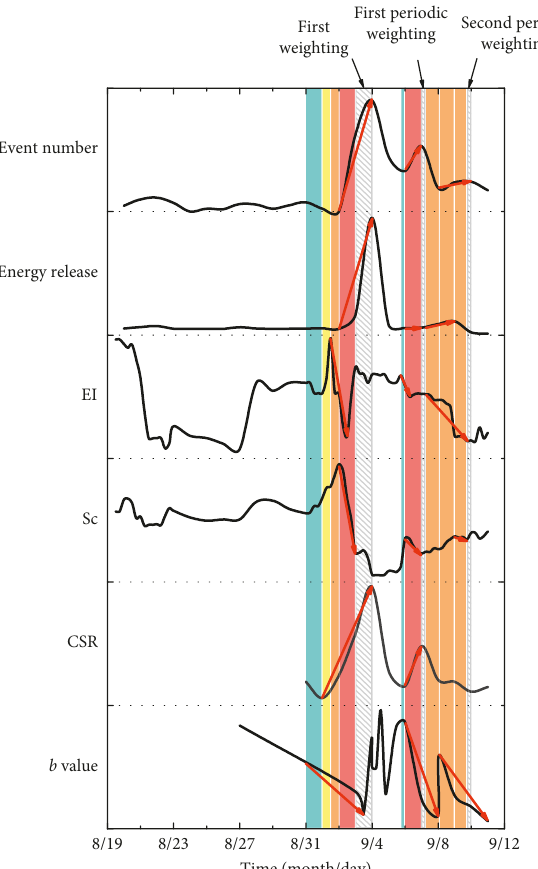
Figure 16: Warning time of MS